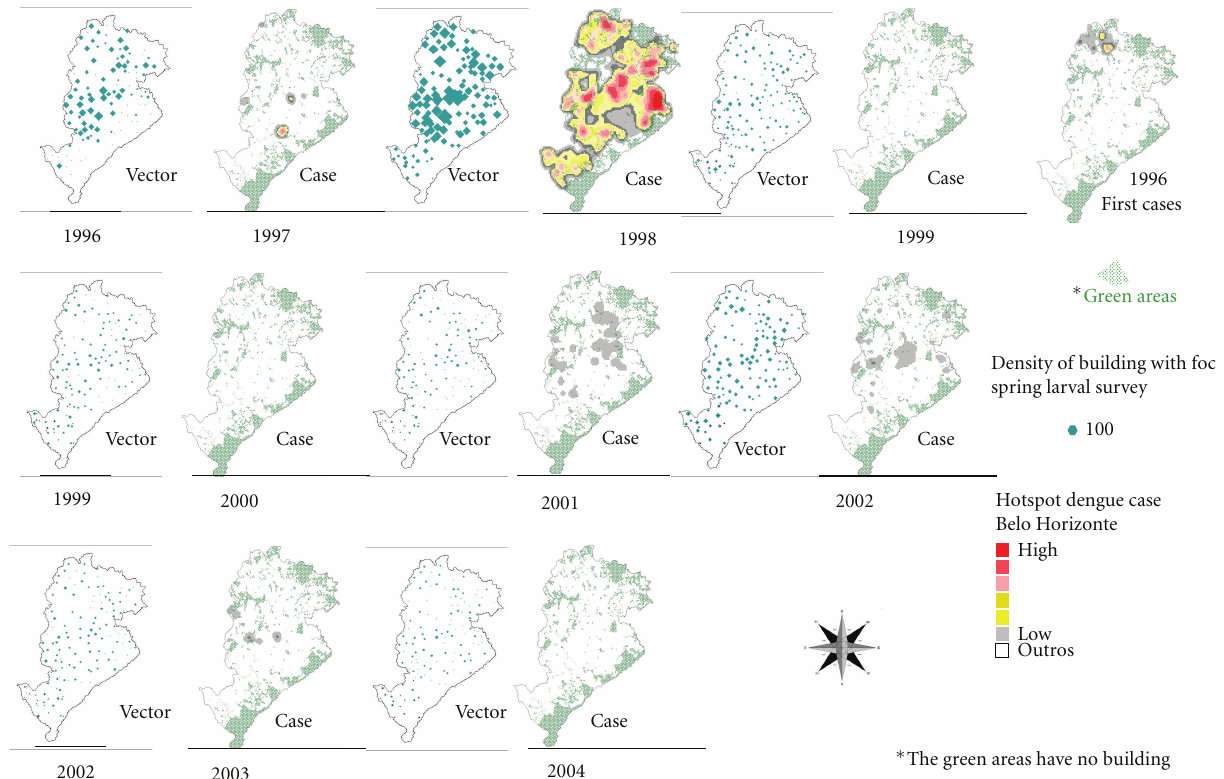
Figure 4: Temporal dynamics in space, foci of Aedes aegypti larvae in October survey and dengue outbreaks, between 1996 and 2004, Belo Horizonte/MG,